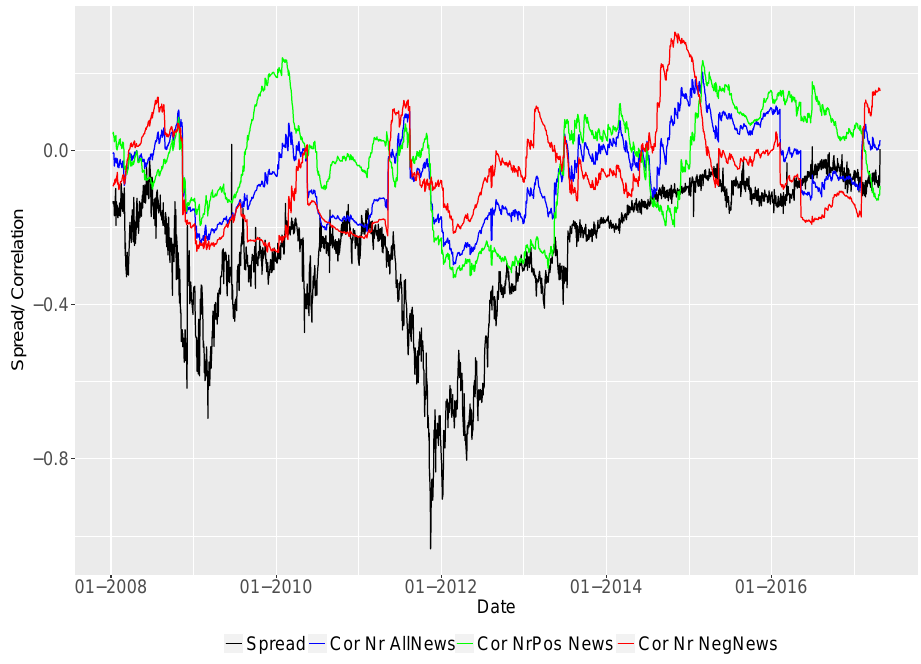
Figure 5. News volume and its rolling correlation with a mean spread of long-term German sovereign